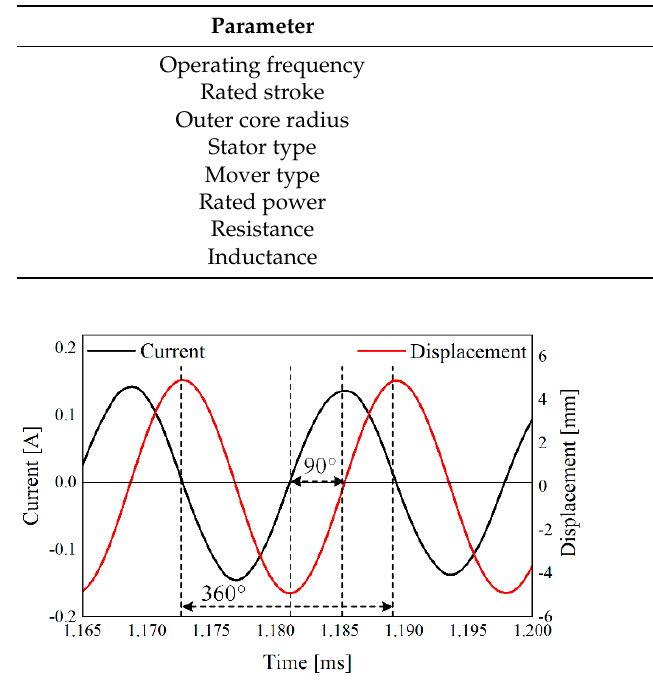
Figure 12. Current and displacement analysis results.